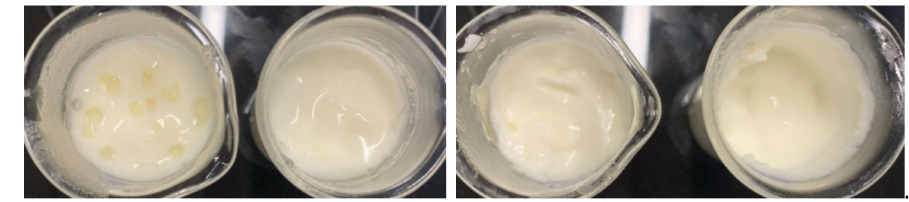
Figure 2. Left: Emulsion after 4 days: left: emulsion with 7% w / w whey protein isolate (WPI) solution; right: emulsion with 8% w / w WPI solution; oil content 73% w / w . Right: Emulsion after 4 days: left: emulsion with 7% w / w sodium caseinate solution; right: emulsion with 8% w / w sodium caseinate solution; oil content 73% w / w .